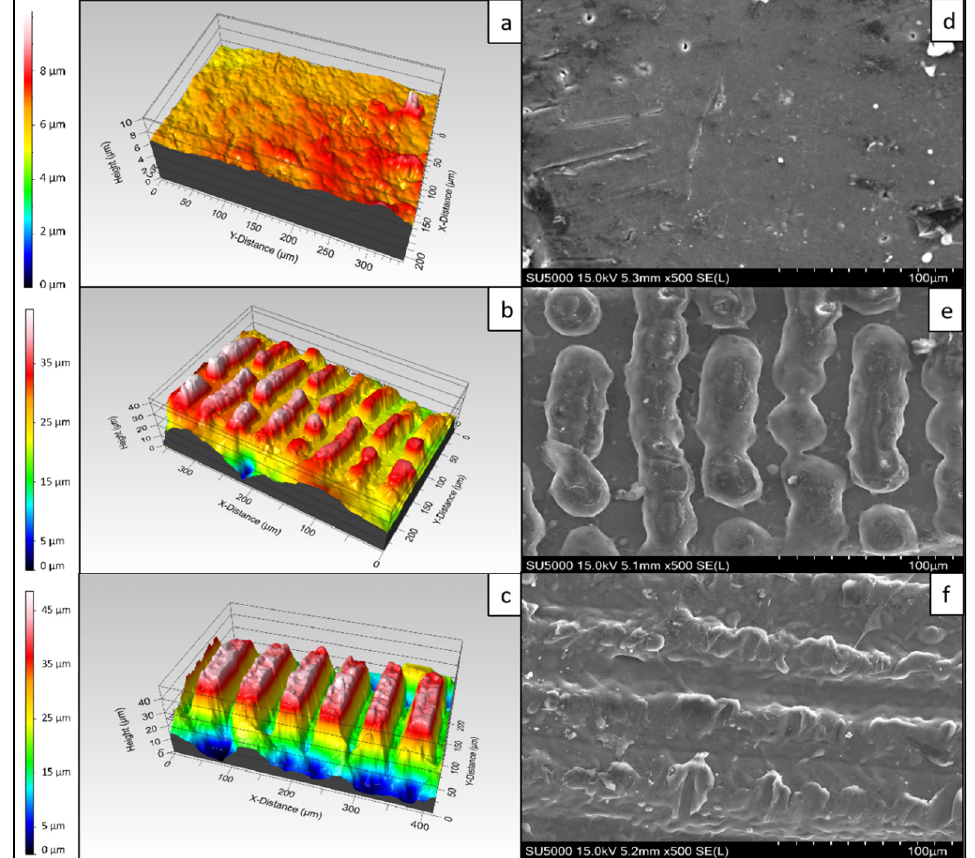
Figure 1. 3D and SEM profiles of PCL scaffolds irradiated with an fs-laser. ( a , d ) Control sample; ( b , e ) A fiber of the polymeric scaffold processed with F = 0.08 J/cm 2 ; N = 2; ( c , f ) A fiber of the polymeric scaffold processed with F = 0.08 J/cm 2 ; N = 10.